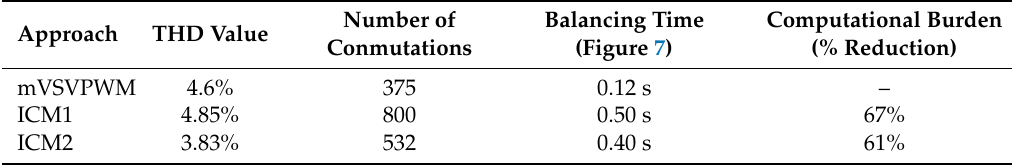
Figure 8. Experimental results: Harmonic spectrum and total harmonic distortion (THD) value of phase a current for the three approaches considered: mVSVPWM, ICM1 and ICM2. Table 2. Main features of the considered